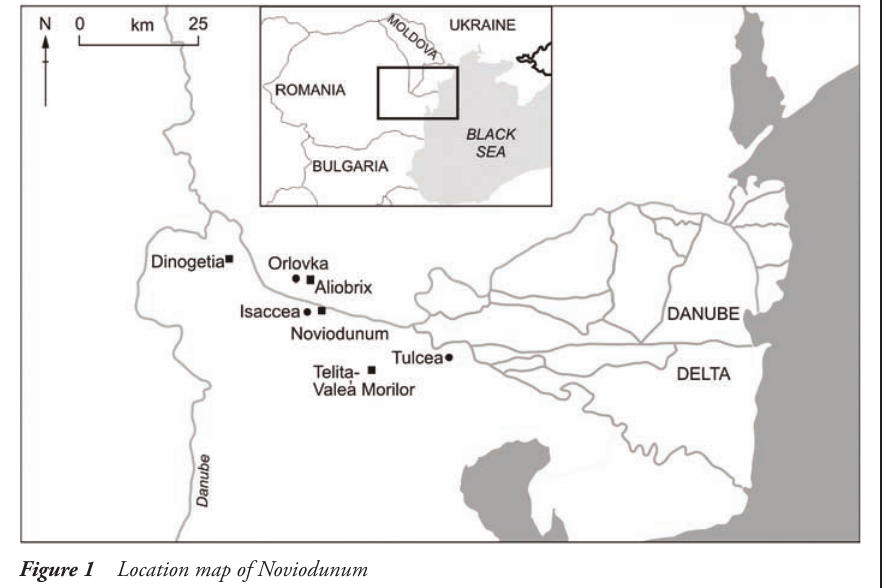
Figure 1 Location map of Noviodunum